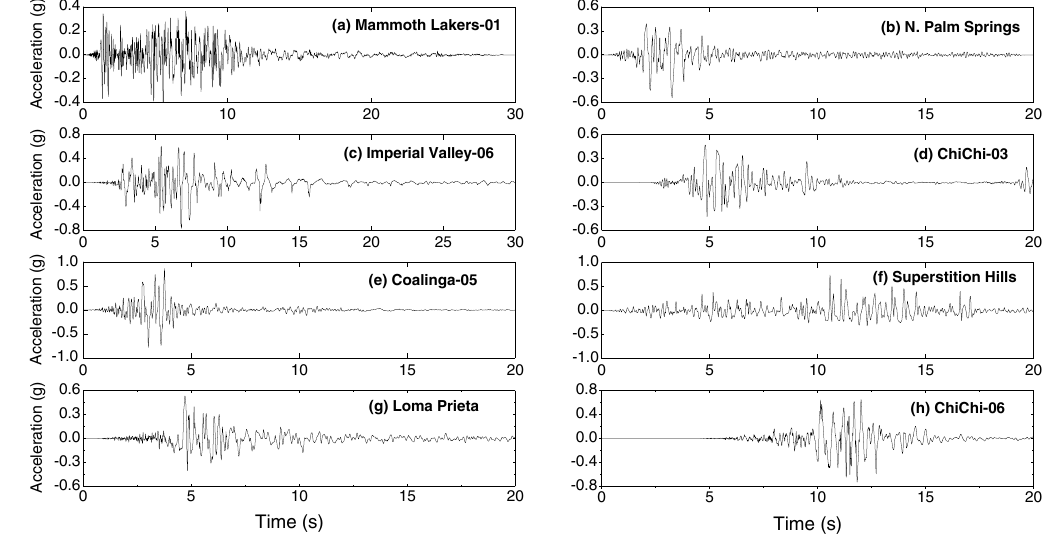
Figure 14. Eight time history recommendations for Hualien (site f) with DSHA calculations and the NGA strong-motion database.